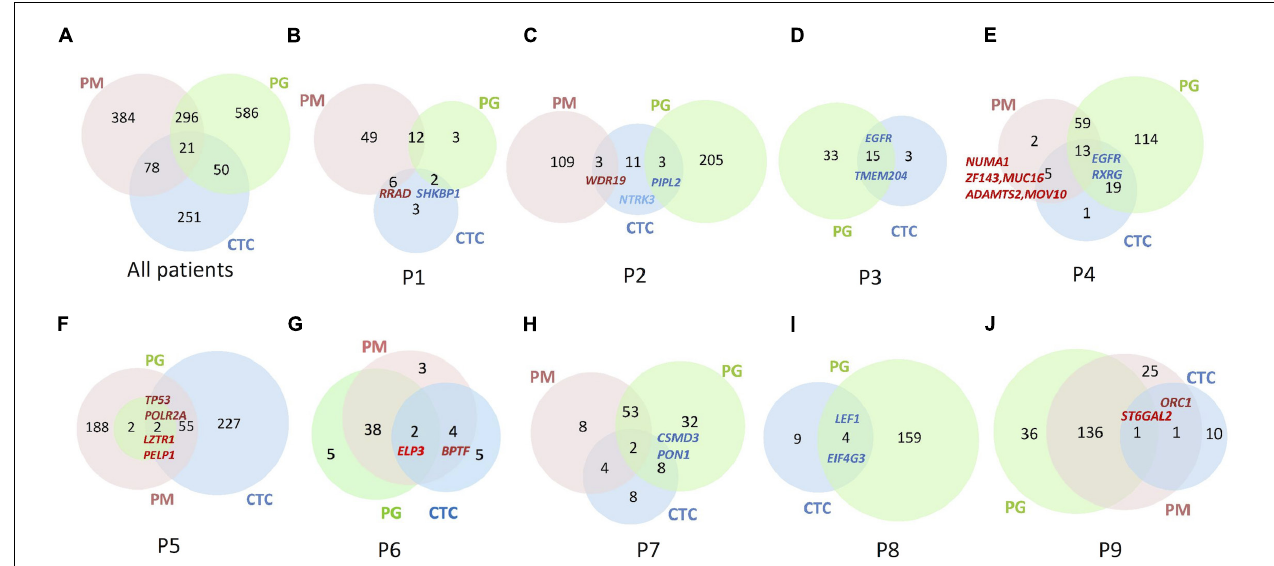
FIGURE 3 | Venn diagrams to show numbers of SNVs/Indels identified in the lung PM, PG, and CTC specimens. (A) Summary of all nine patients. (B–J) Each patient from Patient 1 to 9. Numbers in Venn diagrams referred to gene numbers. Some essential mutation genes identified are indicated at the corresponding samples. Gene names in bright red denote the mutations shared among PM, PG, and CTC specimens; gene names in dark red denote shared between primary specimens and CTCs; gene names in blue denote shared between progressive specimens and